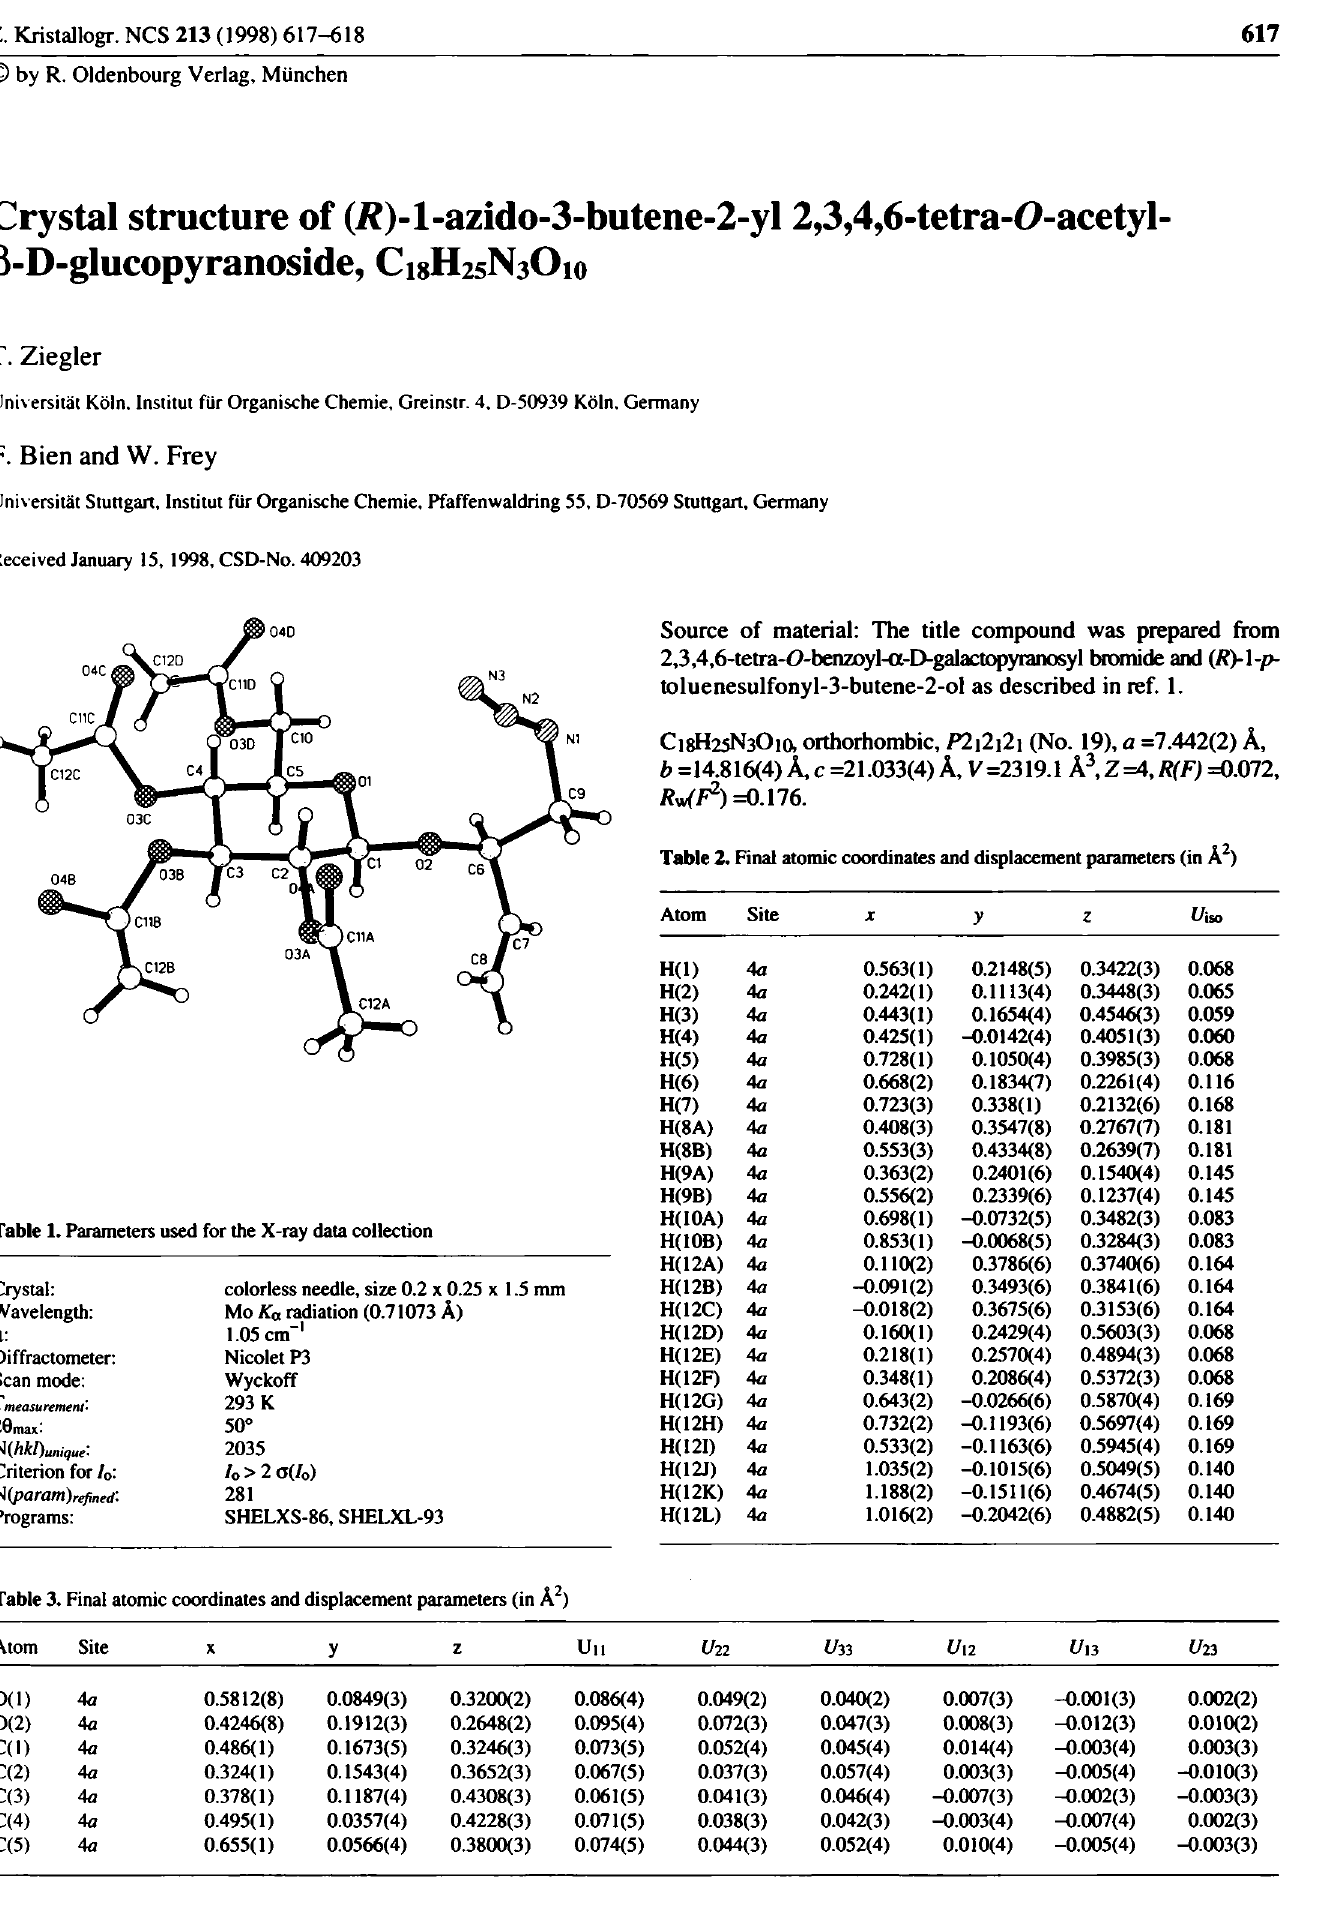
Table 1. Parameters iise.d for the X-ray data collection